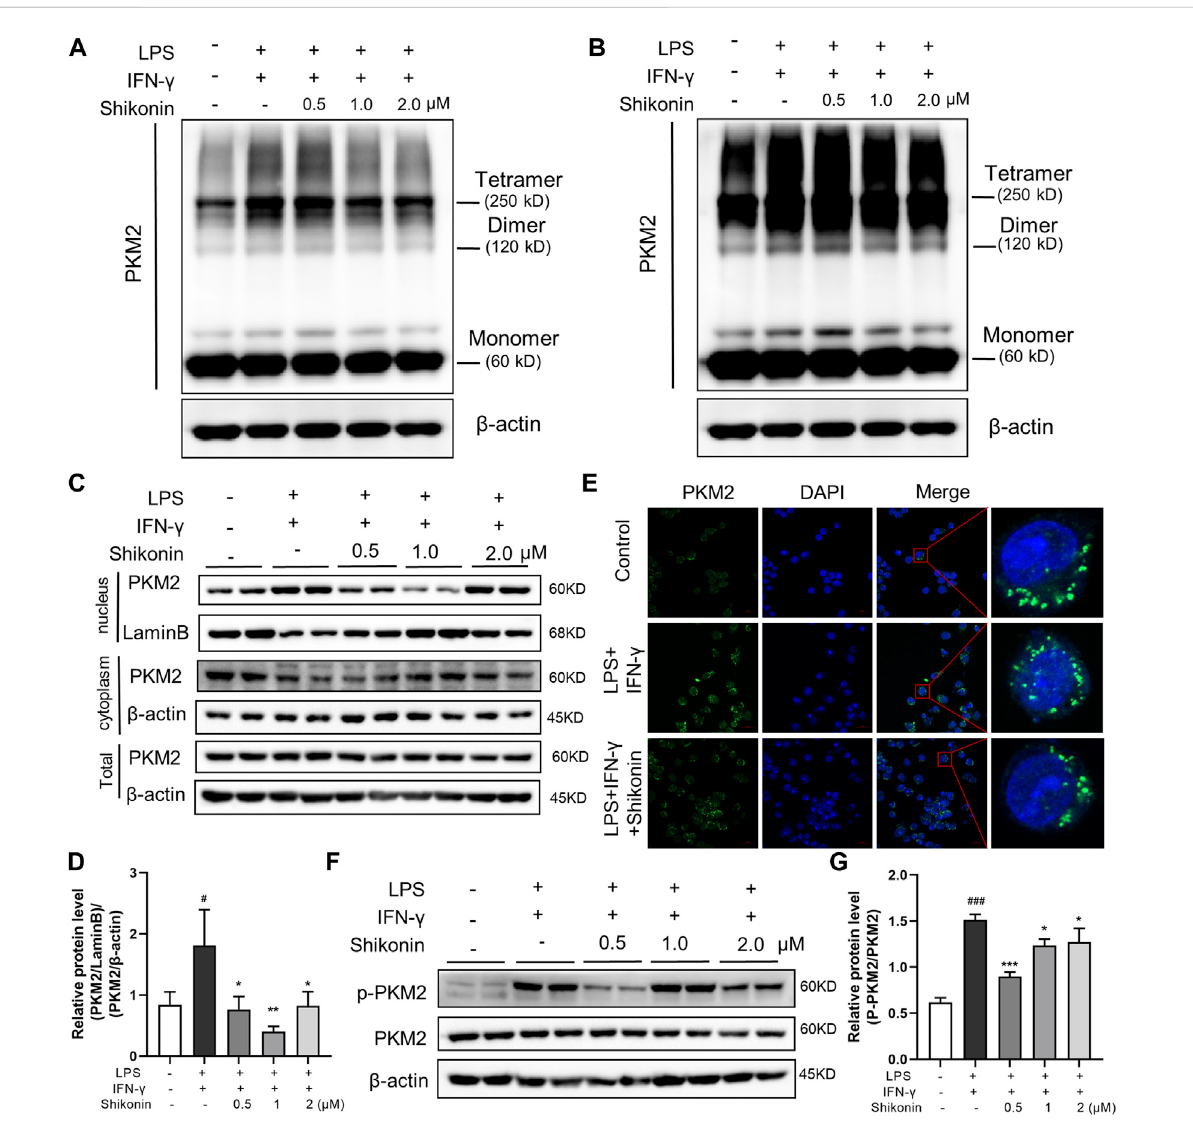
FIGURE 6 Shikonin regulated PKM2 polymerization and inhibited its nuclear translocation and phosphorylation and in RAW264.7 cells. Cells were collected and cross-linked with DSS. Tetramer, dimer and monomer form of PKM2 in RAW264.7 cells were analyzed by western blot (A,B) . (A) showed the effect of short exposure and (B) showed the effect of long exposure. PKM2 in nucleus and in cytoplasm and the statistics were detected by western blots (C) with statistics (D) . Cellular localization of PKM2 was analyzed by immuno fl uorescence staining (E) . The nucleus was stained with DAPI. Expression of P-PKM2 and PKM2 and were detected by western blots (F) with the statistics (G) . Data are shown as the mean ± SD, n = 3. # p < 0.05, ### p < 0.001, compared to the control group. * p < 0.05, ** p < 0.01, *** p < 0.001, compared to the LPS + IFN- γ